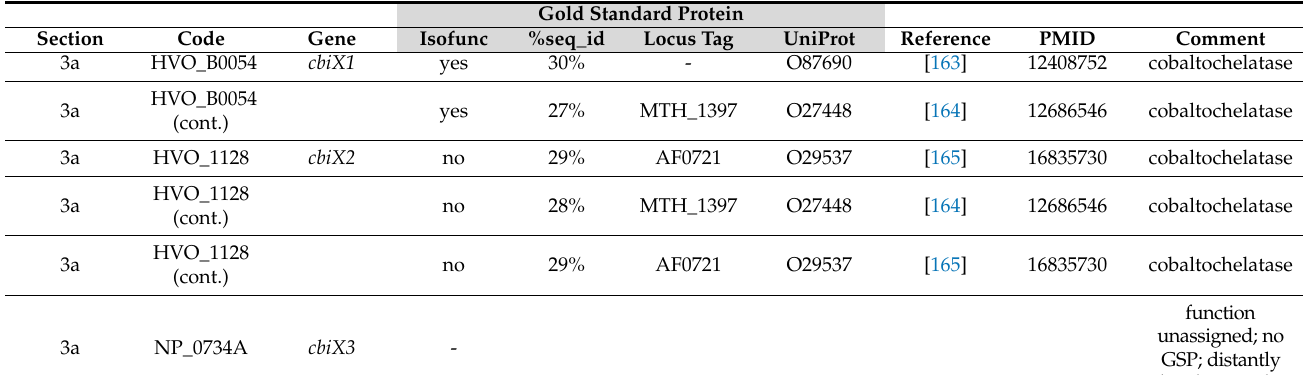
Table 3. Proteins with open annotation issues and their Gold Standard Protein homologs (Section 3.3). For a description of this table, see the legend to Table